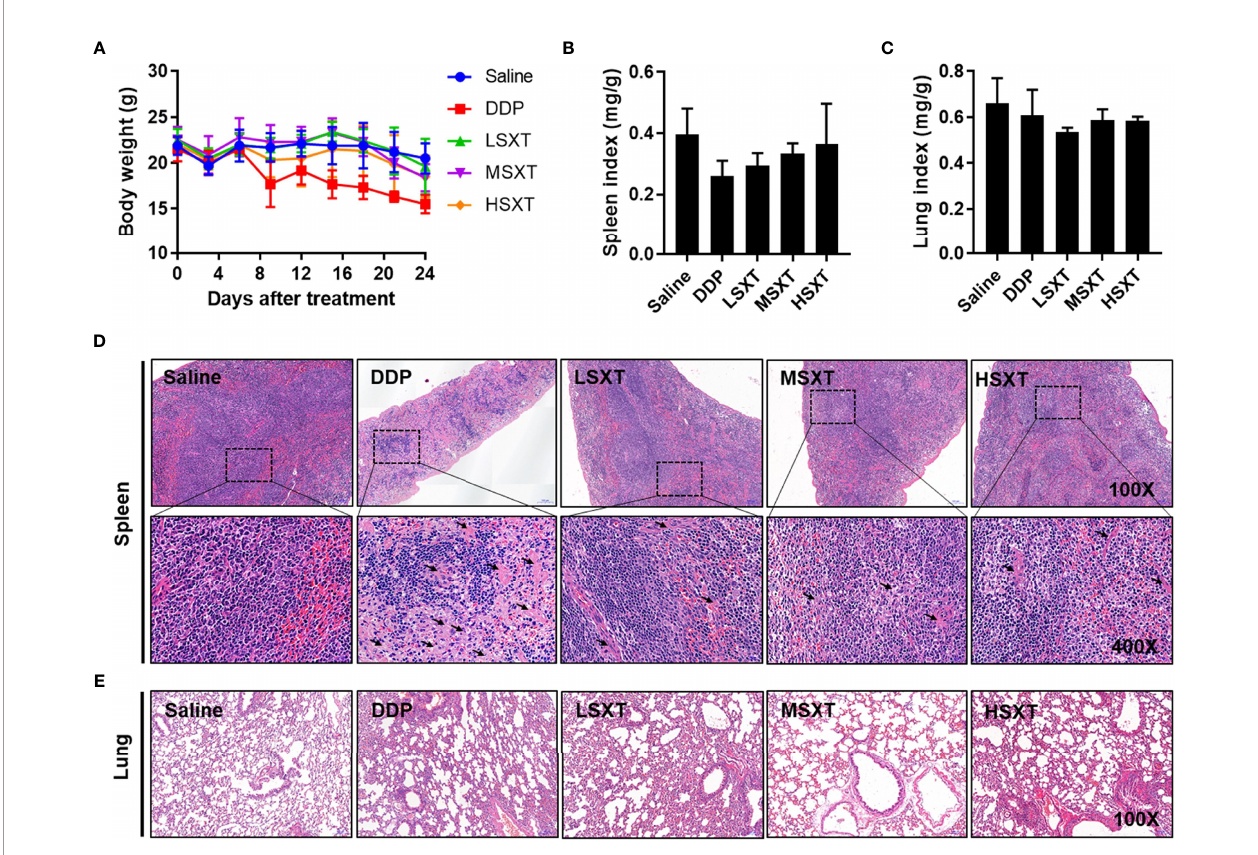
FIGURE 6 | Toxicological evaluation of SXT. (A) Average body weight of mice showing no loss during treatments. Spleen (B) and lung (C) indices of mice following administrations of 0.9% saline, DDP (22.36 mg/kg/d) and low (9.55 g/kg/d; LSXT), medium (28.65 g/kg/d; MSXT) and high (38.20 g/kg/d; HSXT) doses of SXT extract (mean ± S.D., n = 5). The data indicates no signi fi cant difference between SXT and saline control groups. (D) Histological images (magni fi cation: original 100×; enlarged 400×) of spleen in treated mice. Treatment with commercial drug DDP induces pathological changes in the spleen tissue, whereas SXT exhibits no sign of toxicity. Black arrow indicates the germinal centre. (E) Observation of lung histopathology showing no abnormal changes at the tested doses of all the